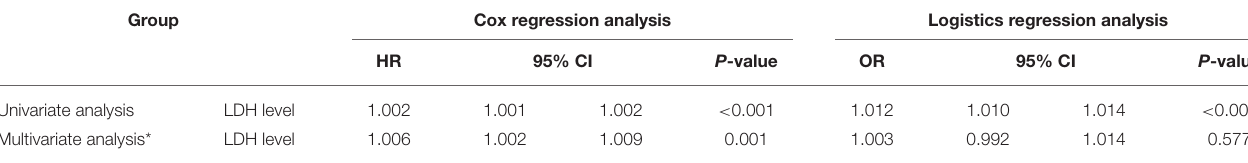
TABLE 4 | Univariate and multivariate cox regression analysis for the survival of patients and logistics regression analysis for the severity of patients when taking LDH as a continuous variable.